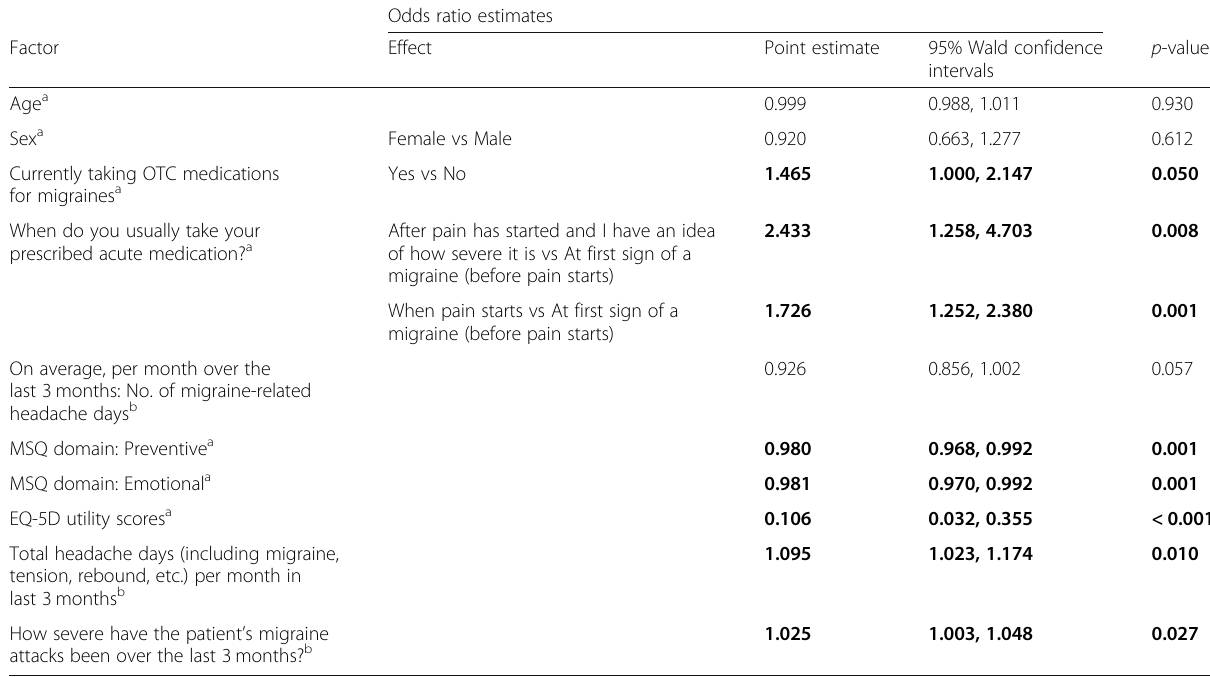
Table 5 Logistic regression modeling triptan insufficient response with backward selection results. P-values in bold indicate statistically significant factors ( N =